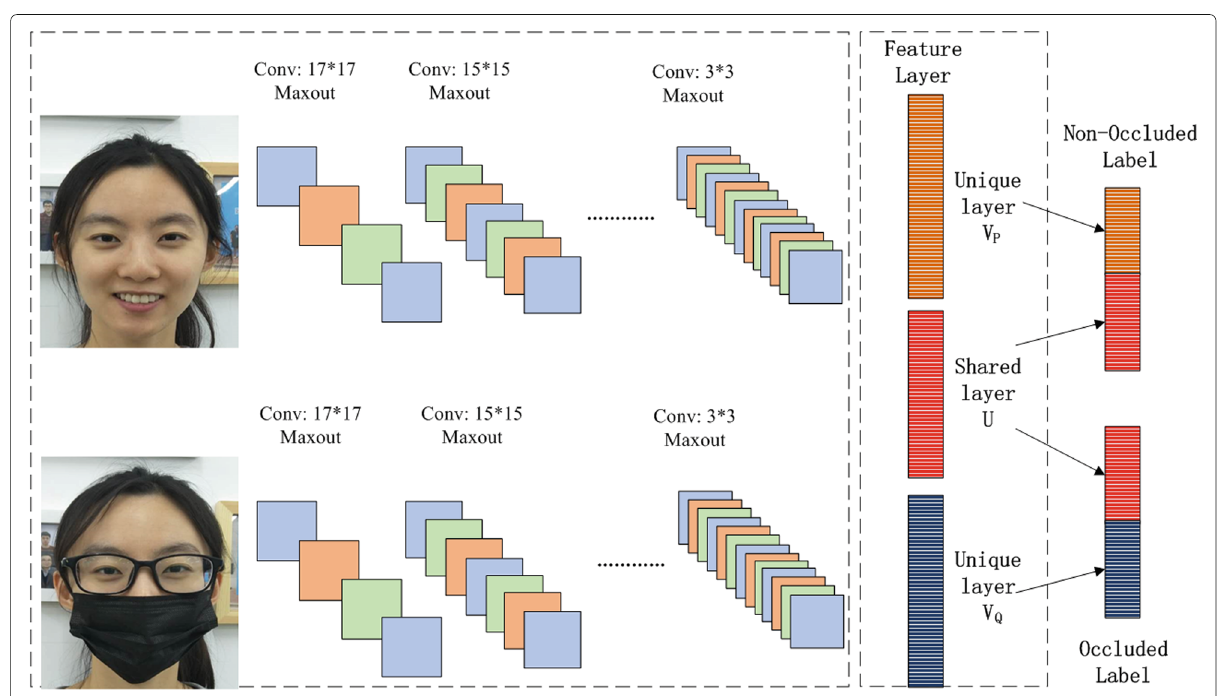
Fig. 1 Our proposed CNN architecture. The maxout operator is used to extract invariant features and avoid the possibility of overfitting. Both the features from the occluded face and its corresponding non-occuluded counterpart can be extracted from the shared layer and compared in cosine